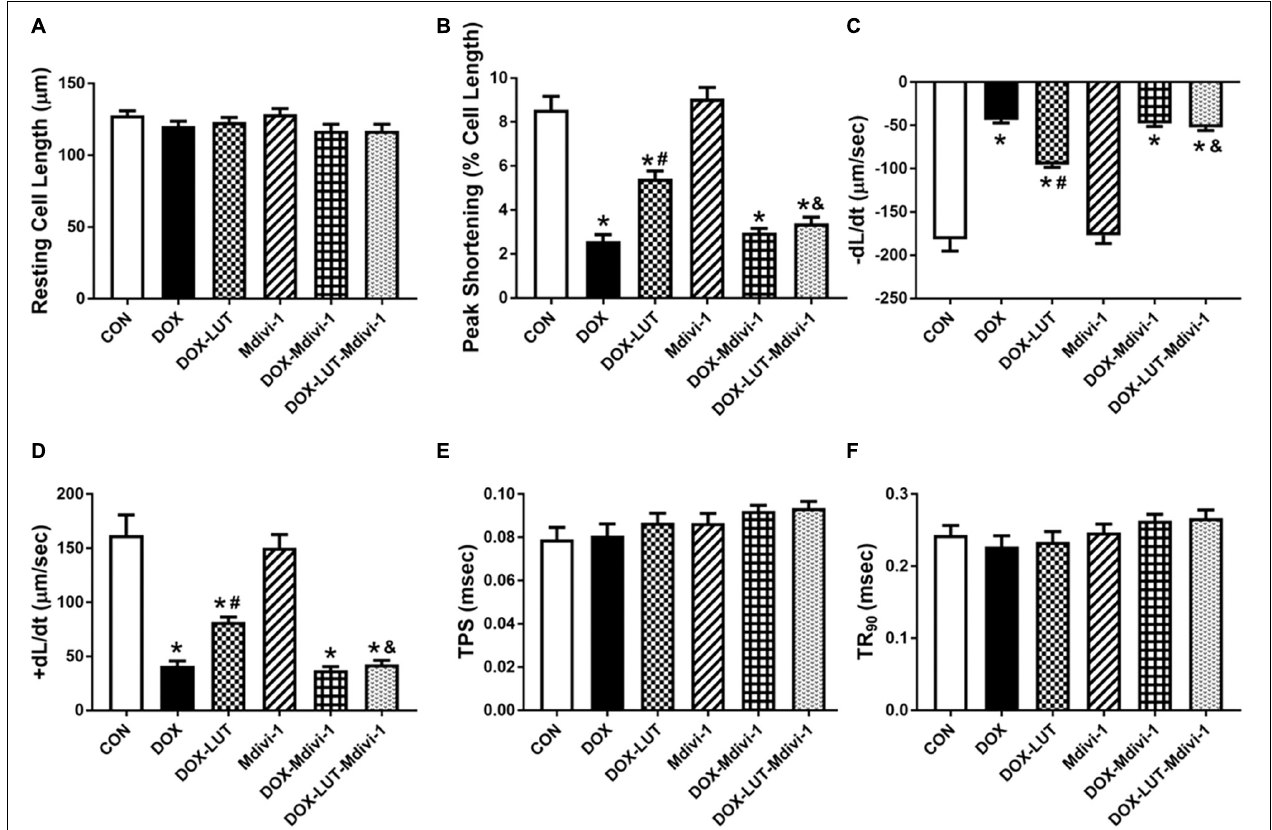
FIGURE 7 | The effect of Mdivi-1 on cardiomyocyte contractile function following doxorubicin and luteolin treatment. (A) Resting cell length; (B) Peak shortening (PS); (C) Maximal velocity of shortening (–dL/dt); (D) Maximal velocity of relengthening (+dL/dt); (E) Time-to -peak shortening (TPS); (F) Time-to-90% relengthening (TR 90 ). Mean ± SEM, n = 30 cells each group from three independent experiment. * p < 0.05 vs. CON group, # p < 0.05 vs. DOX group, & p < 0.05 vs. DOX-LUT